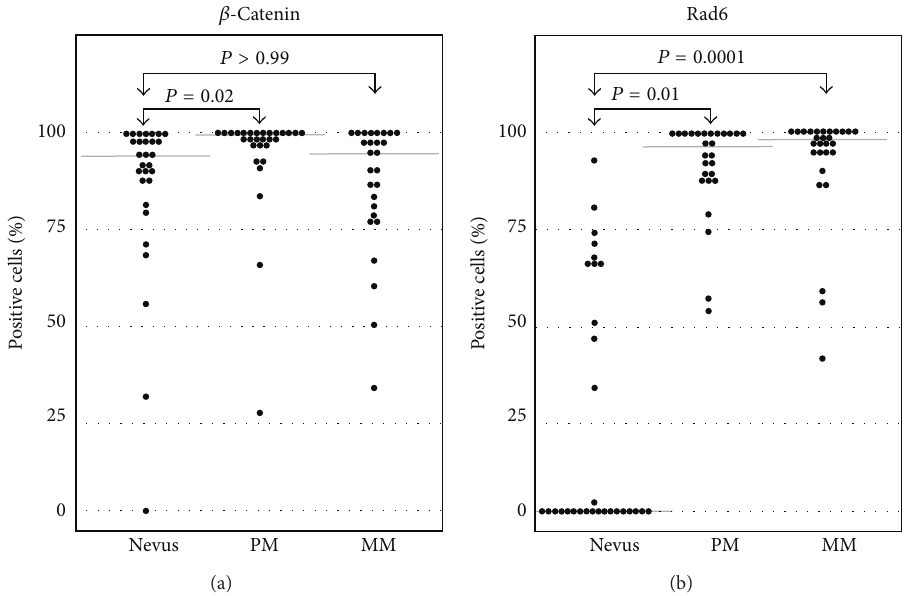
Figure 3: Boxplots of Rad6 and 𝛽 -catenin positive cells in nevi, primary melanoma (PM), and metastatic melanoma (MM). Kruskal-Wallis tests showed that there are significantly more Rad6 positive cells in primary and metastatic melanomas as compared to nevi. Median values are indicated by gray horizontal